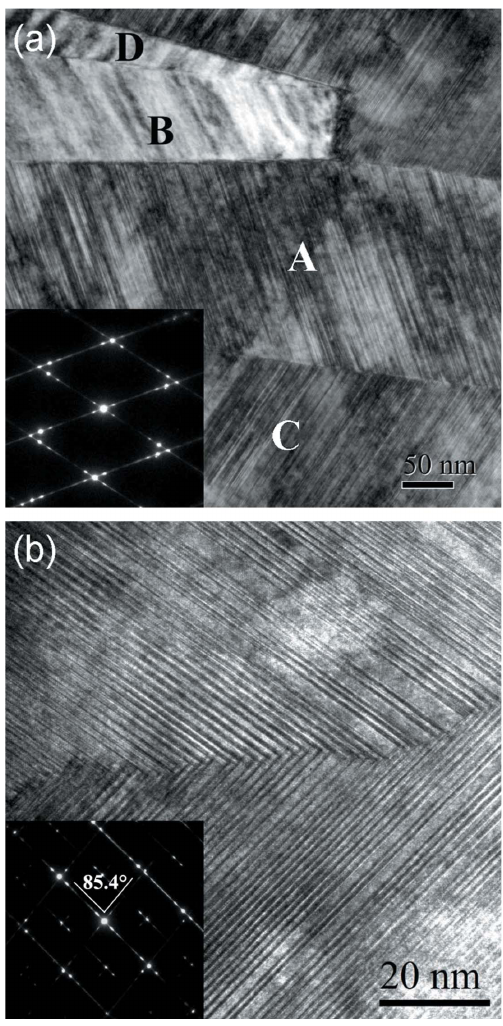
Figure 4 ( a ) A typical bright-field image of 6 M martensite in one variant colony. The inset shows the SAED pattern along the h 210 i M direction for variants A and C. ( b ) A typical TEM image for the compound twin interface. The inset shows the corresponding SAED pattern along the h 010 i M direction for the compound